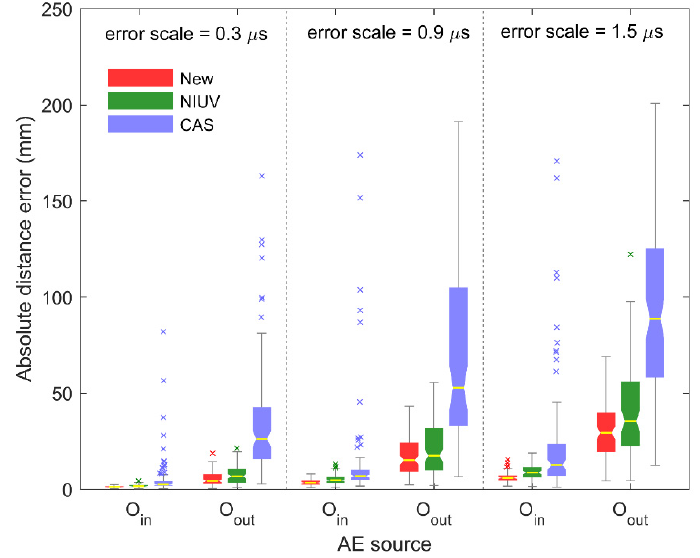
Figure 9. The comparison of the average absolute distance errors between the new method and two traditional methods using arrivals with error scales of 0.3, 0.9, and 1.5 μ s.